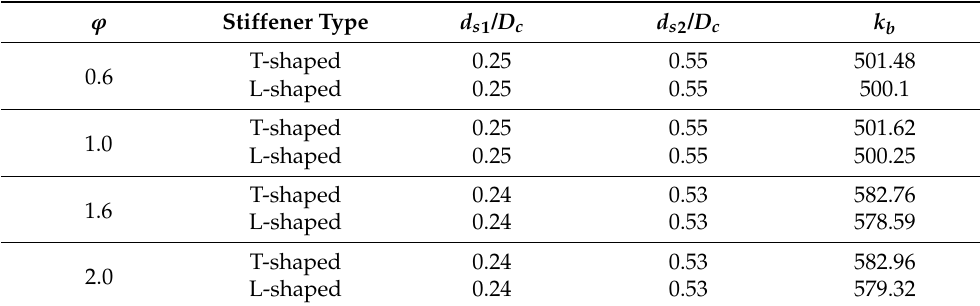
Table 2. Effect of panel aspect ratio on the optimum stiffener locations.